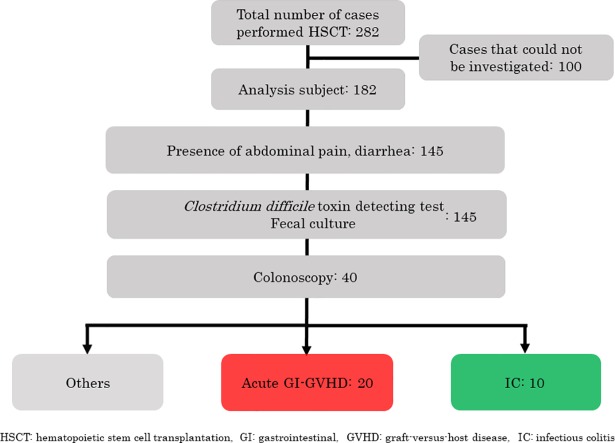
Analysis subject.